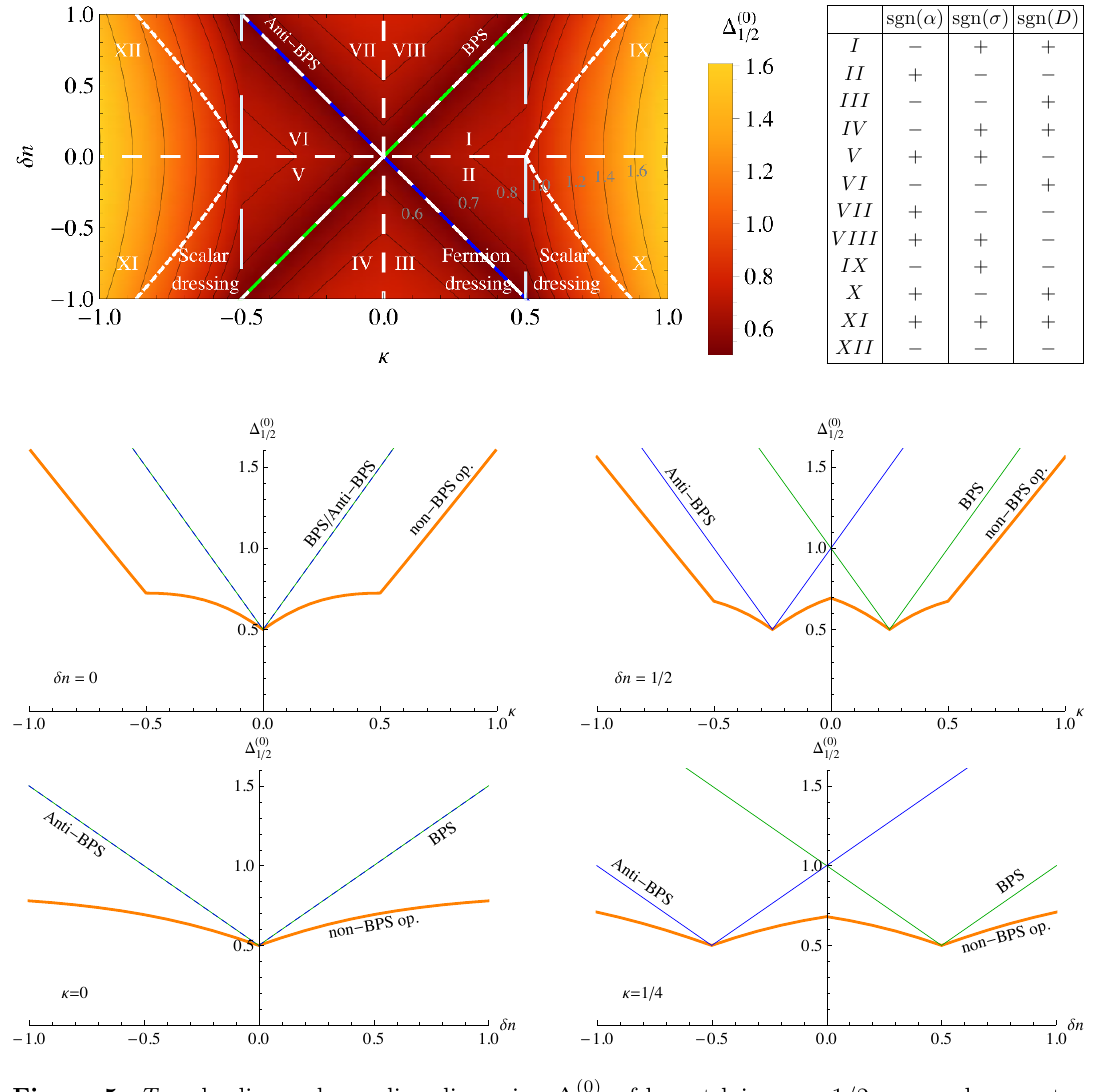
Figure 5 . Top : leading order scaling dimension (cid:1) (0) of lowest lying q = 1 = 2 monopole operator 1 = 2 as a function of (cid:20) (cid:17) k=N and (cid:14)n (cid:17) N + (cid:0) N (cid:0) . Thick dashed lines separate di(cid:11)erent phases described N + + N (cid:0) in the table on the right: the transitions I to IX, II to X, V to XI and VI to XII are smooth in the value of (cid:27) and D , with D changing sign, while all other transitions are discontinuous. For convenience, (cid:27) and D are shown in appendix D.1, in (cid:12)gure 9, for several values of (cid:14)n and (cid:20) . Dashed lines with large dashing separate the regions in which the bare monopole is dressed with fermionic ( (cid:0) 1 = 2 < (cid:20) < 1 = 2) or scalar modes. Along the (anti-)diagonal line the lowest lying monopole is (anti-)BPS and is shown in (blue) green. Center : horizontal bisection of the density plot along the line (cid:14)n = 0 (left) and (cid:14)n = 1 = 2 (right) showing the scaling dimension (cid:1) (0) as a function of (cid:20) . The 1 = 2 (blue) green line shows the (anti-)BPS monopole operator dimension (D.12) and the orange curves show the dimension of the lowest monopole operator. Bottom : vertical bisection of the density plot for (cid:20) = 0 (left) and 1 = 4 (right) showing the scaling dimension (cid:1) (0) as a function of (cid:14)n . The color 1 = 2 coding is the same as in the